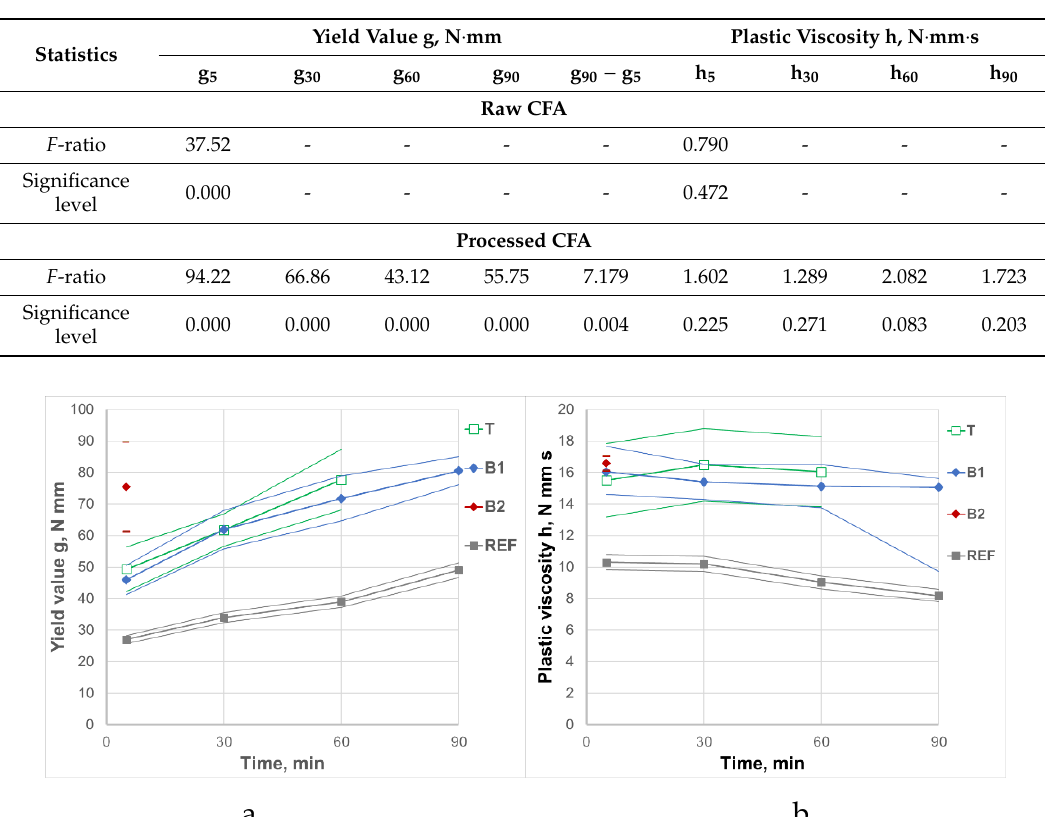
Table 8. ANOVA for the influence of the source of CFA (B1, B2, T) on rheological properties of mortars.